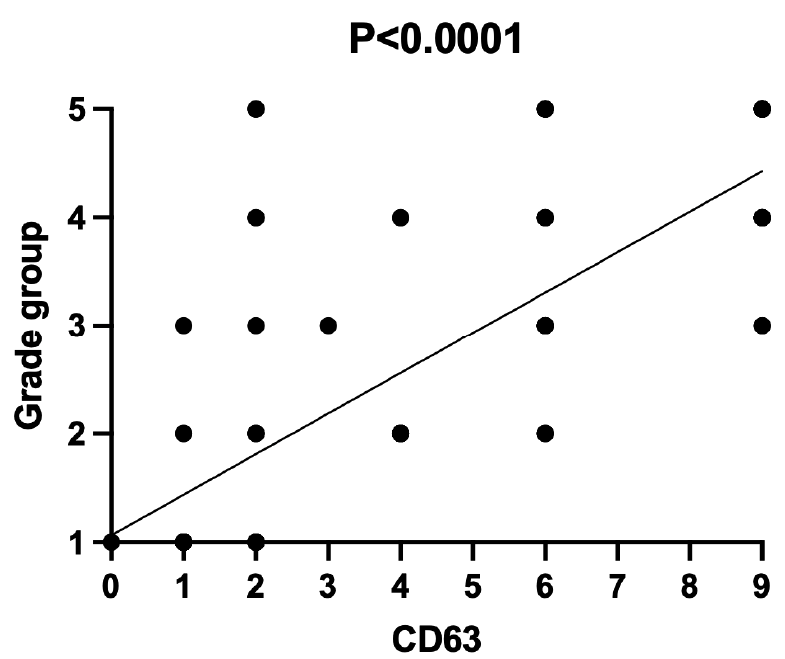
Figure 1. Association between CD63 expression and grade group via Pearson’s chi-squared test ( χ 2 ). Pearson’s χ 2 = 0.59; p < 0.0001.